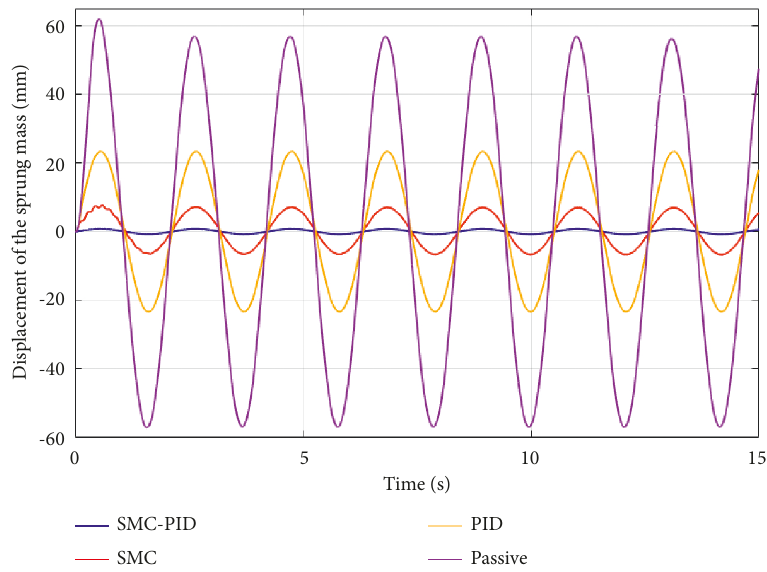
Figure 4: Displacement of the sprung mass (Case